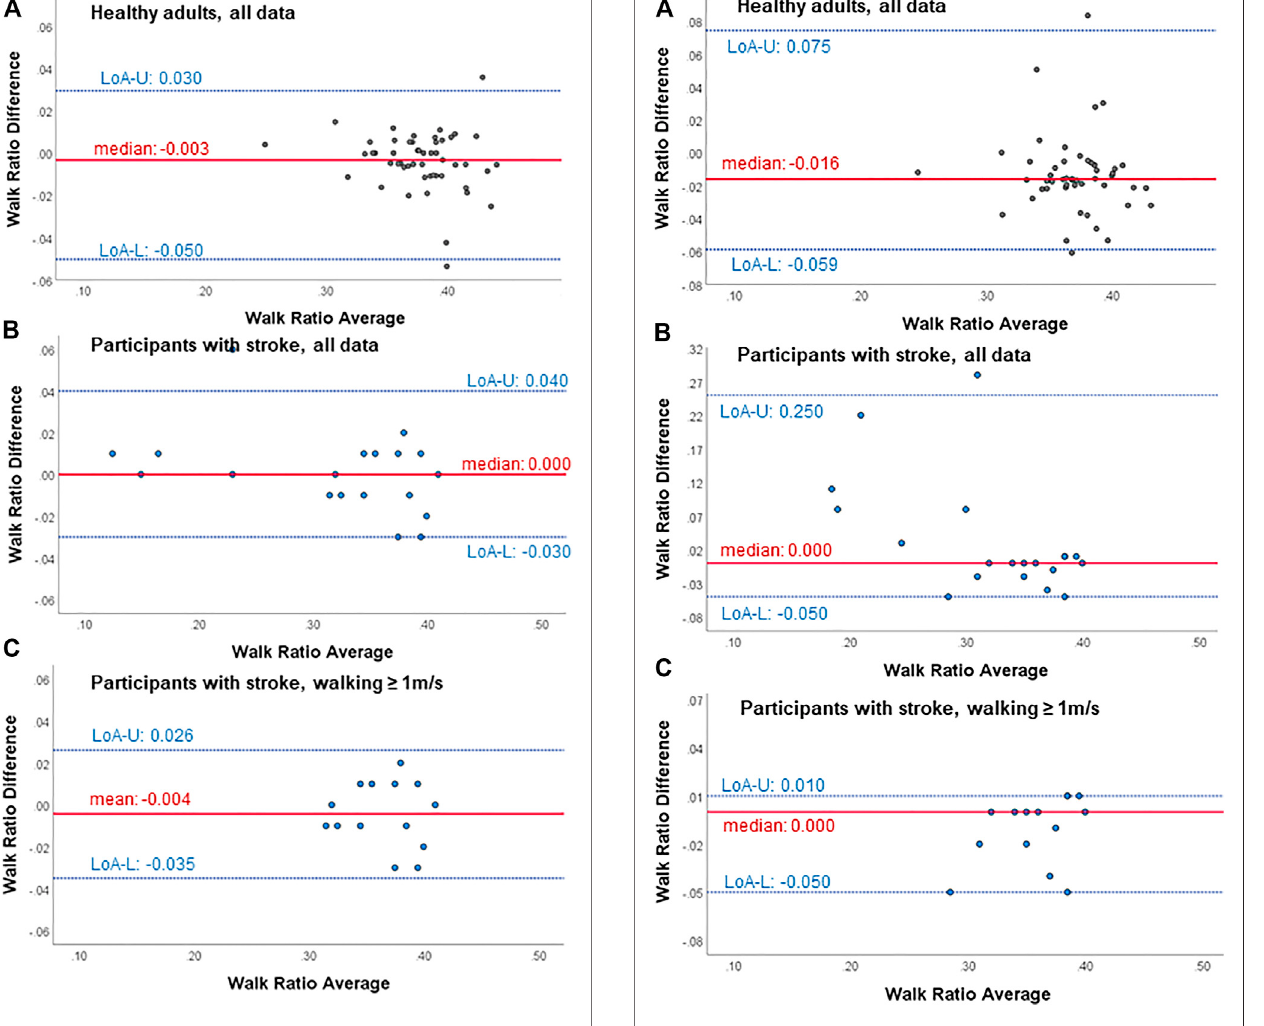
FIGURE 2 | Bland-Altman plots for agreement with the gold standard (SAM3) of the walk ratio from the wearable-based outdoor walk ratio assessmentin (A) healthyparticipants( n =50), (B) allparticipantswithchronic stroke ( n = 20) and (C) participants with chronic stroke walking ≥ 1 m/s ( n = 14). Diff, difference; LoA-U, upper limit of agreement; LoA-L, lower limit of